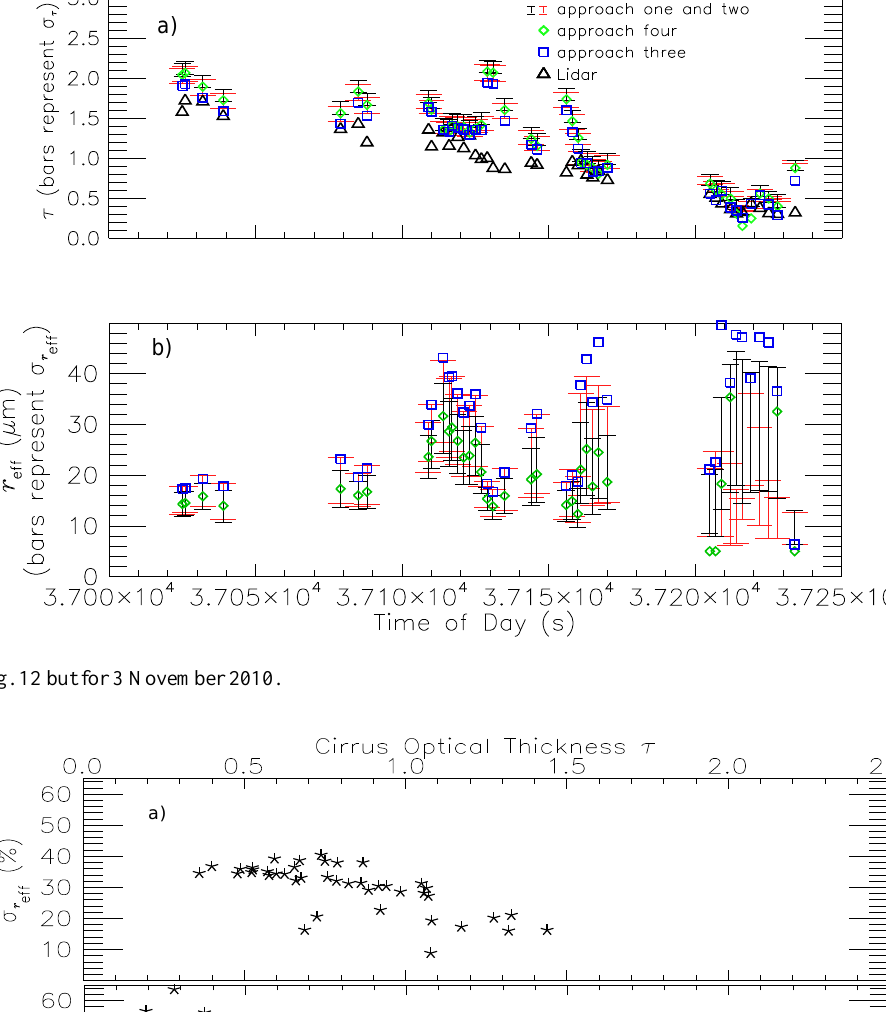
Fig. 15. Correlation between standard deviation of r reff and τ for the 4 November (a) and 3 November (b) timeseries derived of HALO-SR measuements using surface albedo approach two.